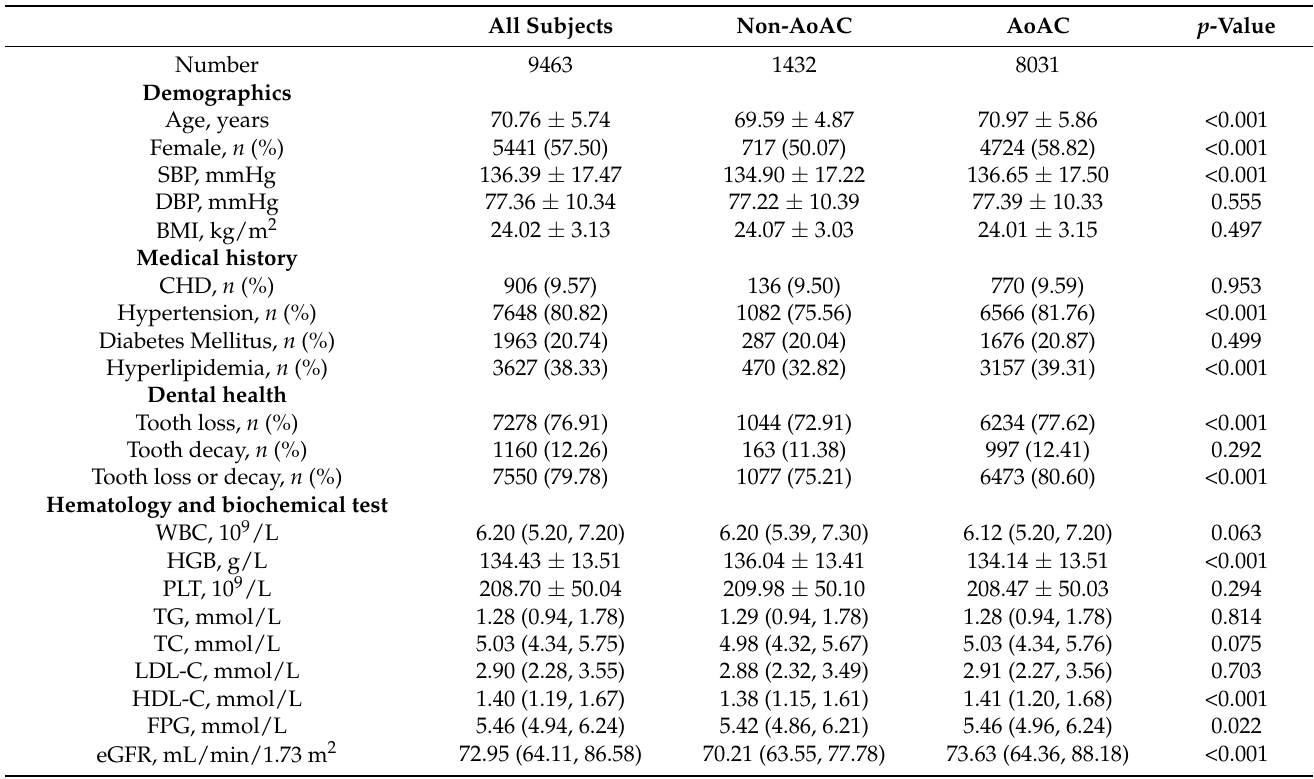
Table 1. Characteristics of participants according to the presence of